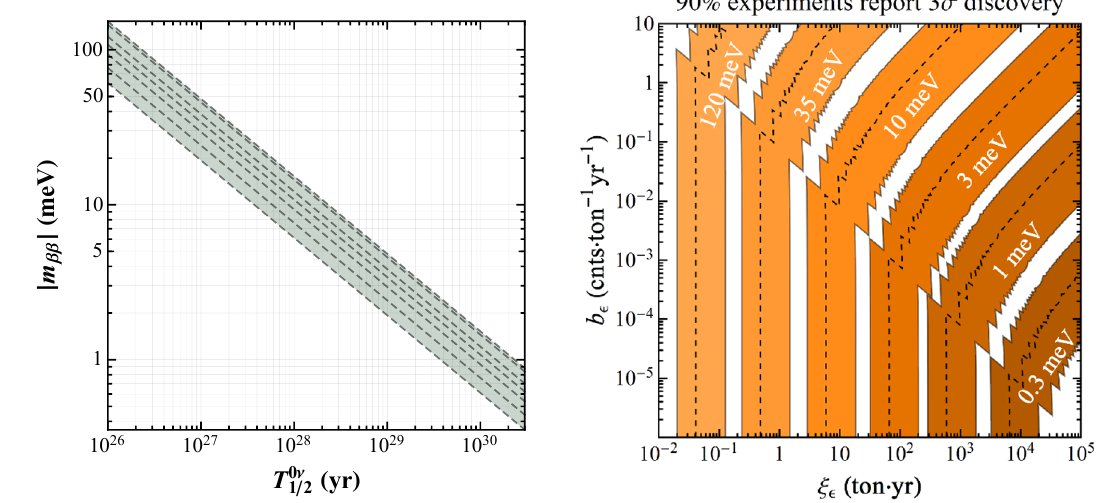
of 136 Xe and the effective neutrino 1 / 2 = 3 . 79 × 10 − 14 yr − 1 and the values of 0 ν ( right panel ). The colored bands in (cid:15) | = 2 . 94 . 0 ν